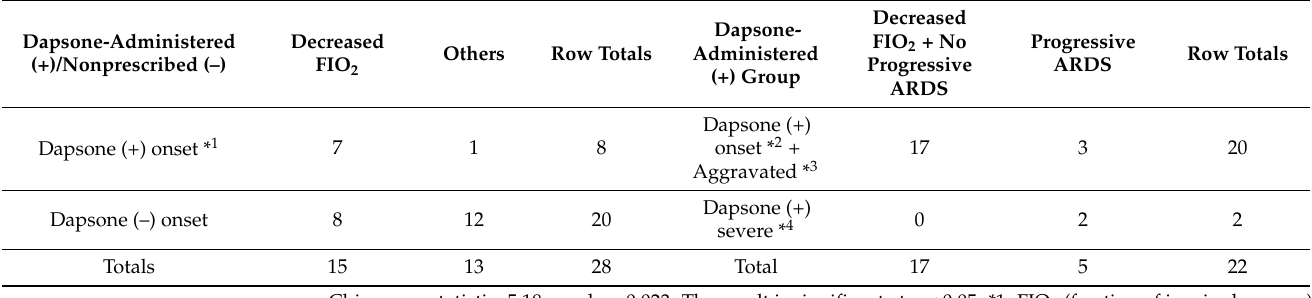
Table 1. Effects of dapsone as applicable to COVID-19 ARDS